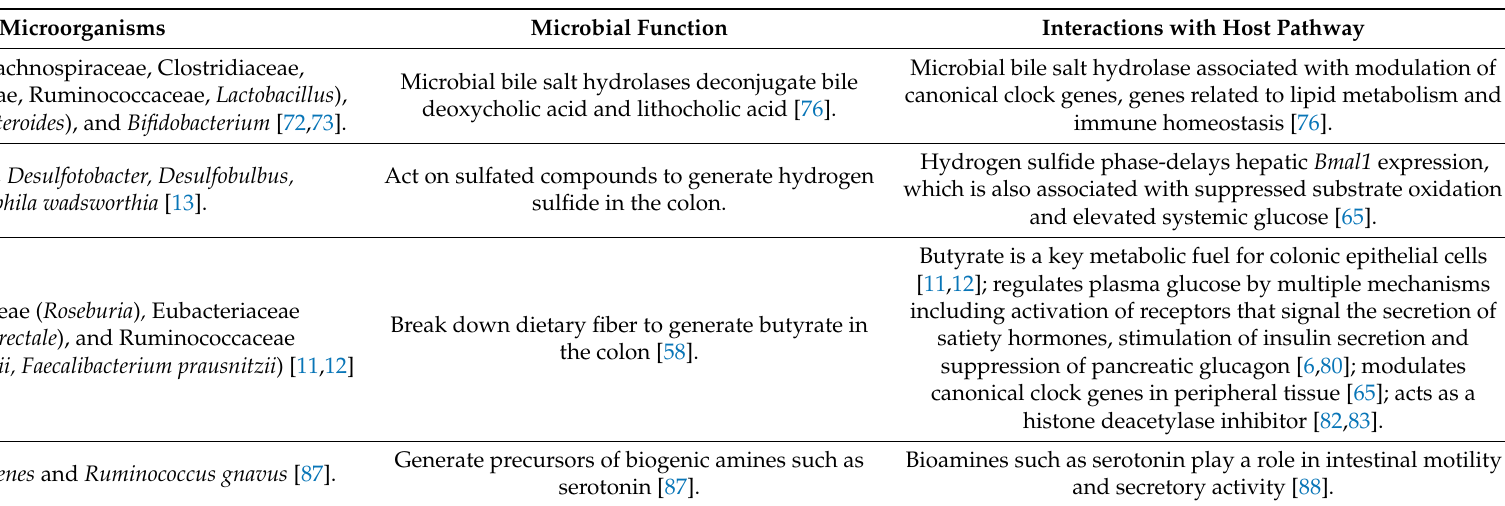
Table 2. Major microbiota-mediated mechanisms that influence host circadian and metabolic pathways